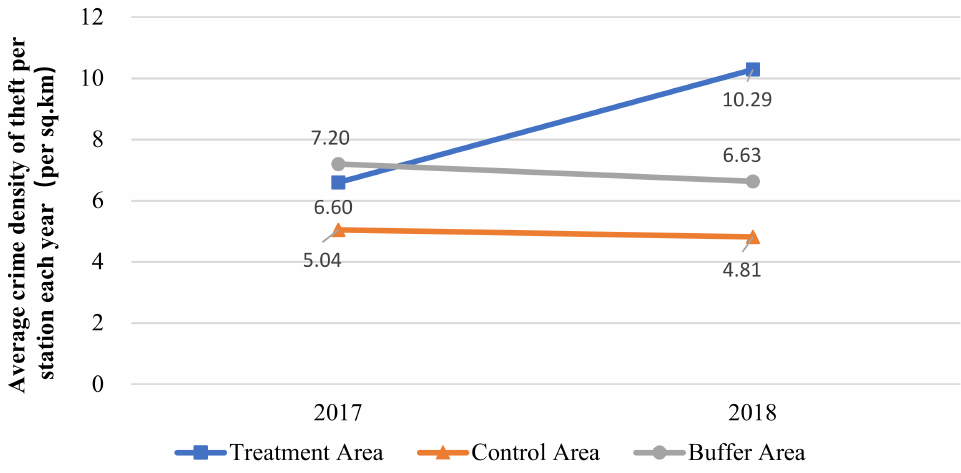
Figure 6. Annual change in theft densities in treatment and control areas in 2017 and